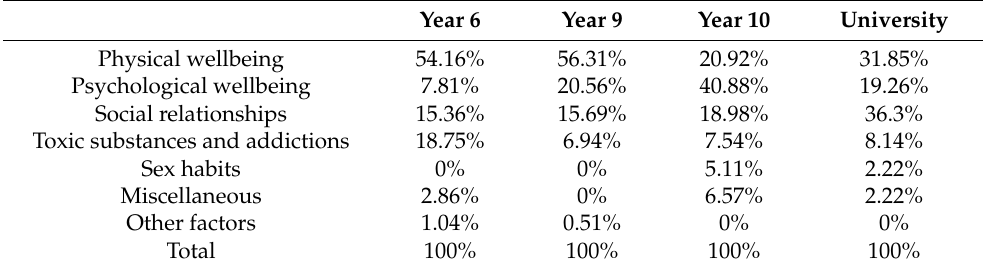
Table 2. Percentages of the points obtained by each category, according to the academic